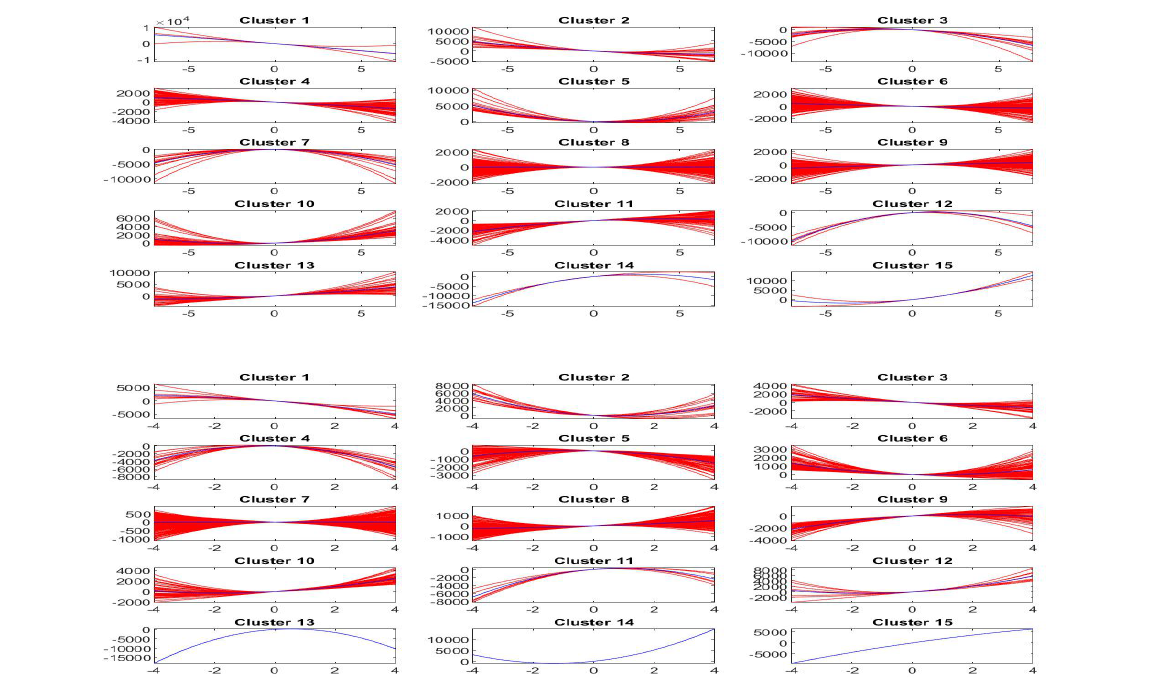
Figure 18. Clustering of L 2 -norm F-transform components (polynomials) of order 2 for Bitcoin series. The clusters correspond to the fuzzy r -partition P a with r = 4 ( bottom picture) and r = 7 ( top